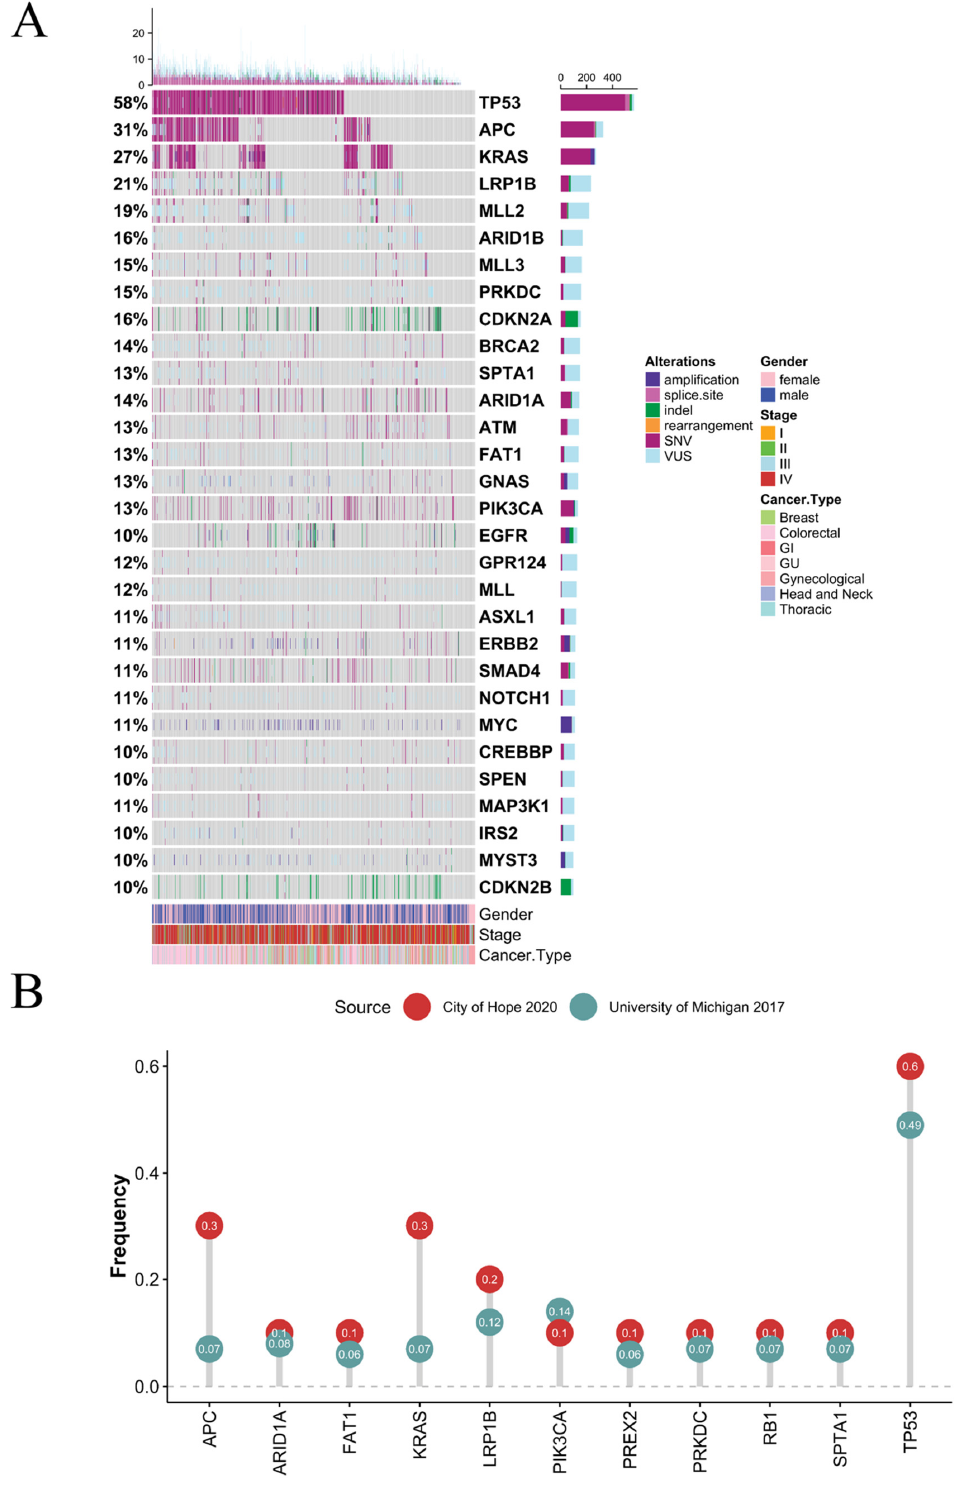
Figure 1. Mutation analysis of 957 patients treated at City of Hope. ( A ) Co-mutation plot of all somatic mutations with a frequency of 6% or more in 957 metastatic cancer patients. Row percentages represent the frequency of gene mutations in the cohort. Each of the column bars represents the number of mutations for each patient. SNV: single nucleotide variants; VUS: variant of unknown significance; GI: gastrointestinal; GU: genitourinary. ( B ) Comparison of most frequent mutations from the City of Hope 2020 and University of Michigan 2017 cohorts of solid metastatic cancer